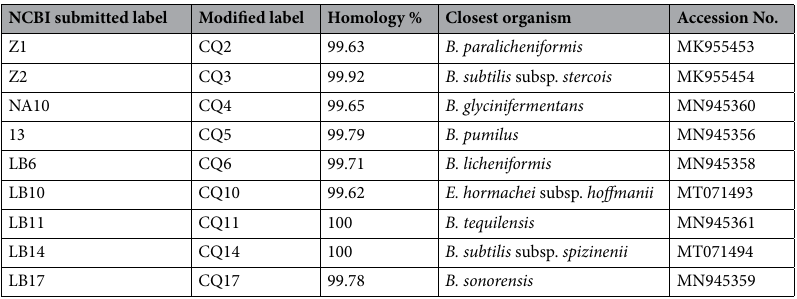
Table 2. Homology of rhizobacterial strains